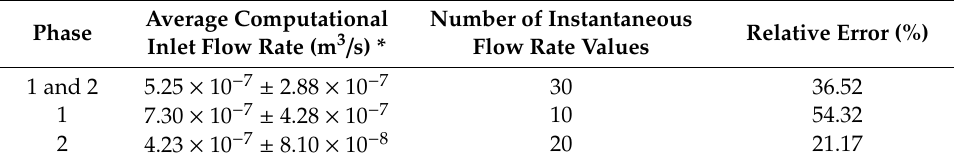
Table 7. Relative error between the computational model and the experimental inlet flow rate for two di ff erent time